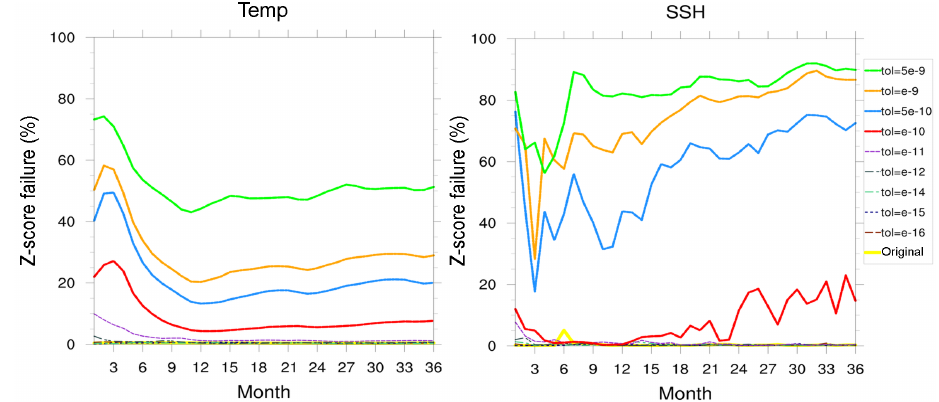
Figure 6. Percentage of grid points with Z -scores for temperature (TEMP) and sea surface height (SSH) that exceed the 3.0 tolerance for simulations with various barotropic solver convergence